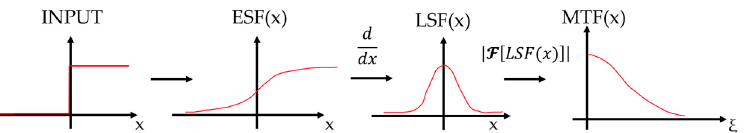
Figure 6. The response of the system to the step input is the edge spread function (ESF), then the spatial derivative of ESF data produces a line spread function (LSF), which is then Fourier transformed into the modulation transfer function (MTF).